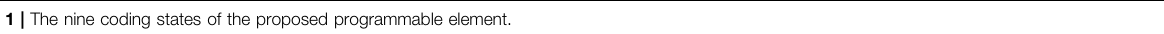
TABLE 1 | The nine coding states of the proposed programmable element. States A 0 A 1 B 0 Phase